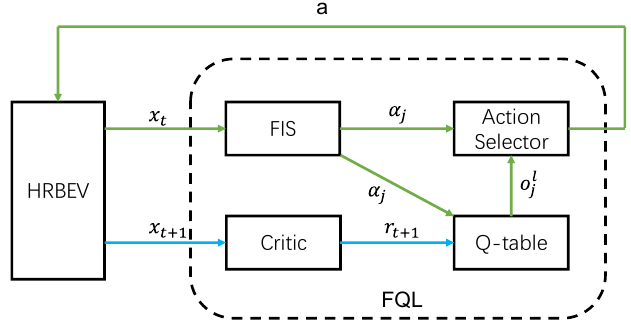
Figure 3. The RBFQL